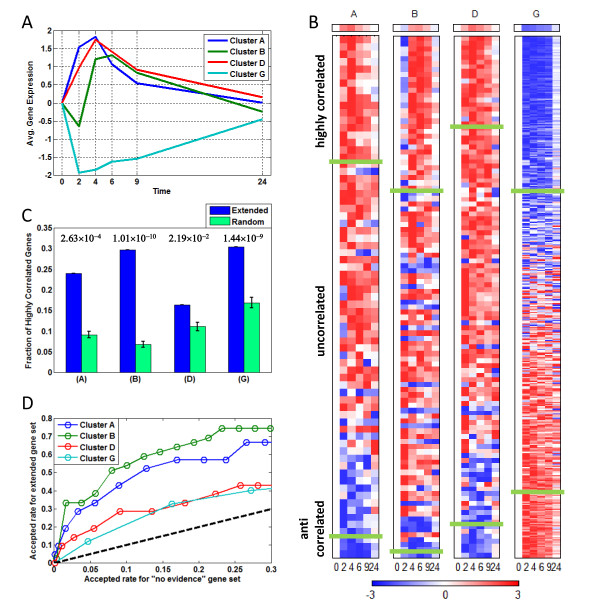
Identification of new target genes for major clusters. (A) The average expression profiles of the four clusters with > 10 members. (B) Expressions of extended regulatory genes sorted by correlation coefficients(c) with the average expression profile of a cluster. Each extended gene group was divided into highly correlated (c > 0.5), un-correlated (t0.5 <c < 0.5) and anti-correlated (c < t0.5) groups. The average gene expression of each cluster is shown as a row at the top of each column. (C) Ratio of highly correlated genes (c > 0.5) in the sets of extended regulatory genes and 1,000 randomly chosen genes. Error bars were calculated as the standard deviation of a population derived from 100 repeated tests. P-values measured by the Fisher's exact test are noted above each column set. (D) Fraction of acceptable new predicted cluster genes from both the extended and "no evidence" gene sets. Significantly expressed genes (p < 0.01) in both sets were plotted against each other using a range of Pearson's coefficient cutoff values for Clusters A, B, D, and G. The dashed line indicates where the fraction of acceptable genes is equal from both the extended and "no evidence" sets